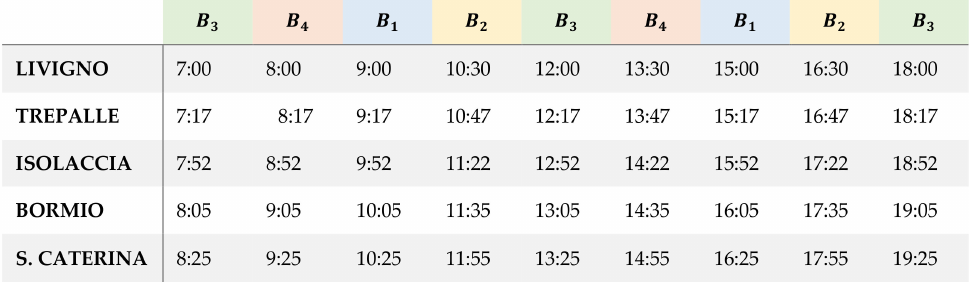
Figure 13. Mid-season Backward.